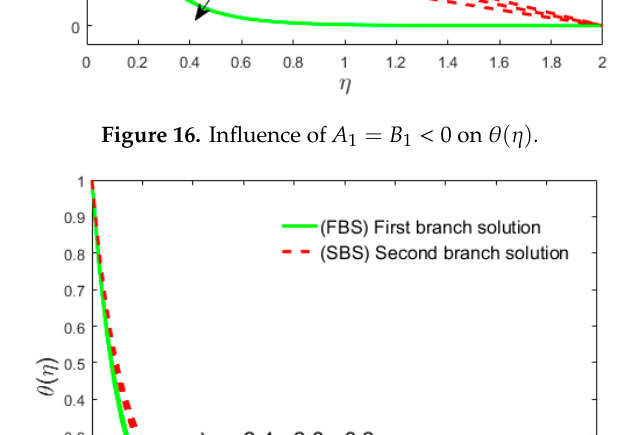
Figure 16. Influence of